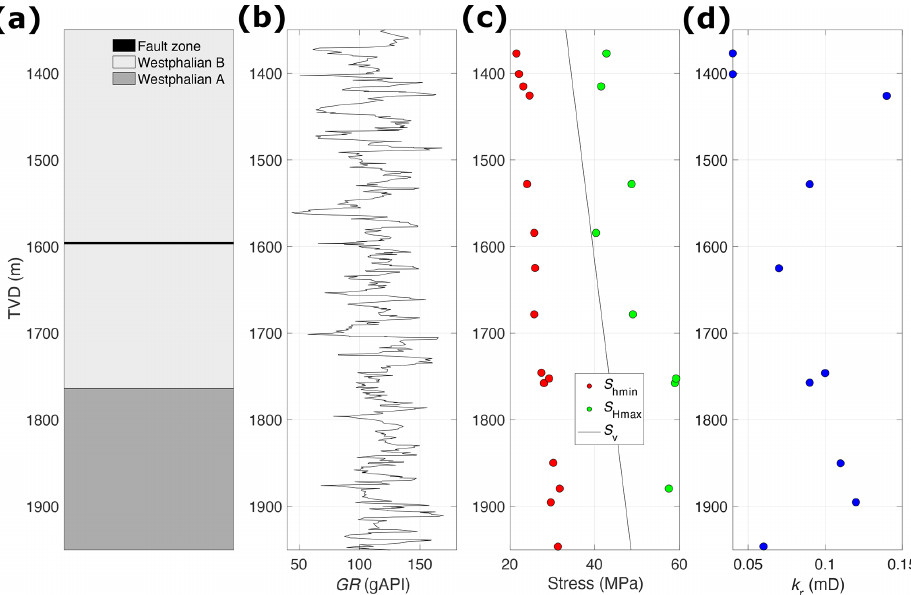
Figure 8. Results of the deeper sections of the Natrap-1 well (TVD – true vertical depth) with (a) lithostratigraphic column, (b) gamma-ray, GR, log (due to high sampling frequency of the gamma-ray log, data was smoothed out), (c) magnitudes of a minimum horizontal stress, S hmin , maximum horizontal stress, S Hmax , and vertical stress, S v , measured in the Natrap-1 borehole ( S v was computed based on a bulk density log available between depth of 1300 and 1970m, with an assumption of bulk density of rock mass of 2500kgm − 3 between surface and depth of 1300m), and (d) measured rock mass permeability, k r .